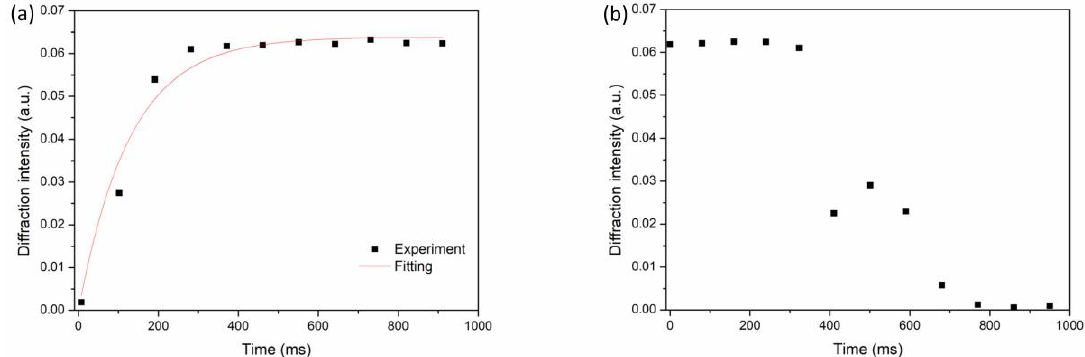
Figure 3. Diffraction efficiency of the first-order diffraction as a function of time ( a ) when the device is operated with an applied voltage of 5.0 V, and ( b ) when the applied voltage is switched off.